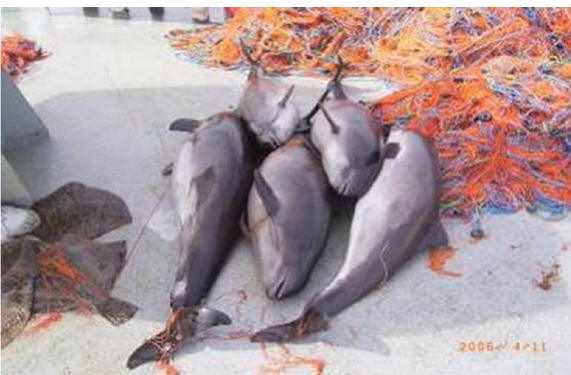
Fig. 6. – Cetaceans incidentally caught in Turkish gillnets, recov- ered by the patrolling boats of the Constan ț a Border